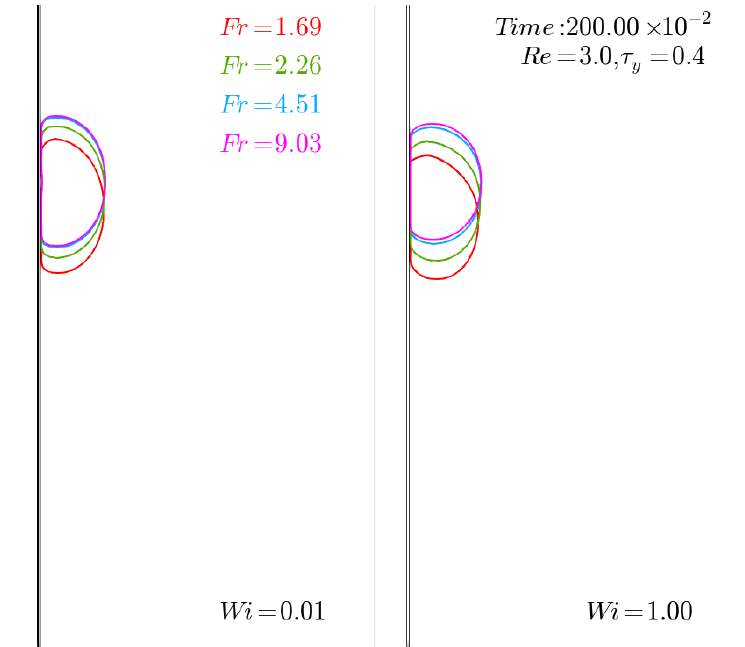
Figure 4. Collision of drops on a vertical wall for fixed values of the Reynolds, Re = 3, and plastic numbers, τ y = 0.4 and the following values of the Froude number, Fr = { 1.69;2.26;4.51;9.03 } . ( left column ) Wi = 0.01; ( right column ) Wi = 1.0. Dimensionless time, t =